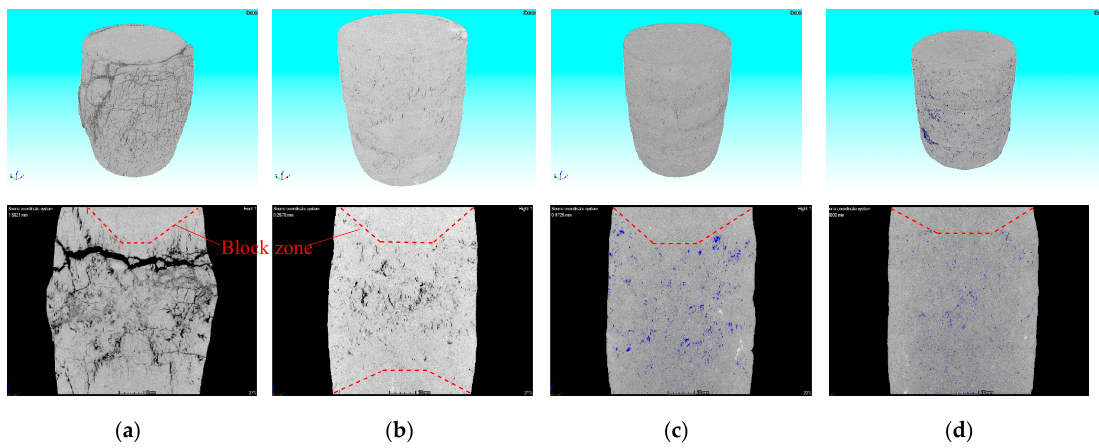
Figure 20. CT images of broken pure salt rock specimens. ( a ) σ 3 = 5 MPa; ( b ) σ 3 = 10 MPa; ( c ) σ 3 = 15 MPa; ( d ) σ 3 = 20 MPa.